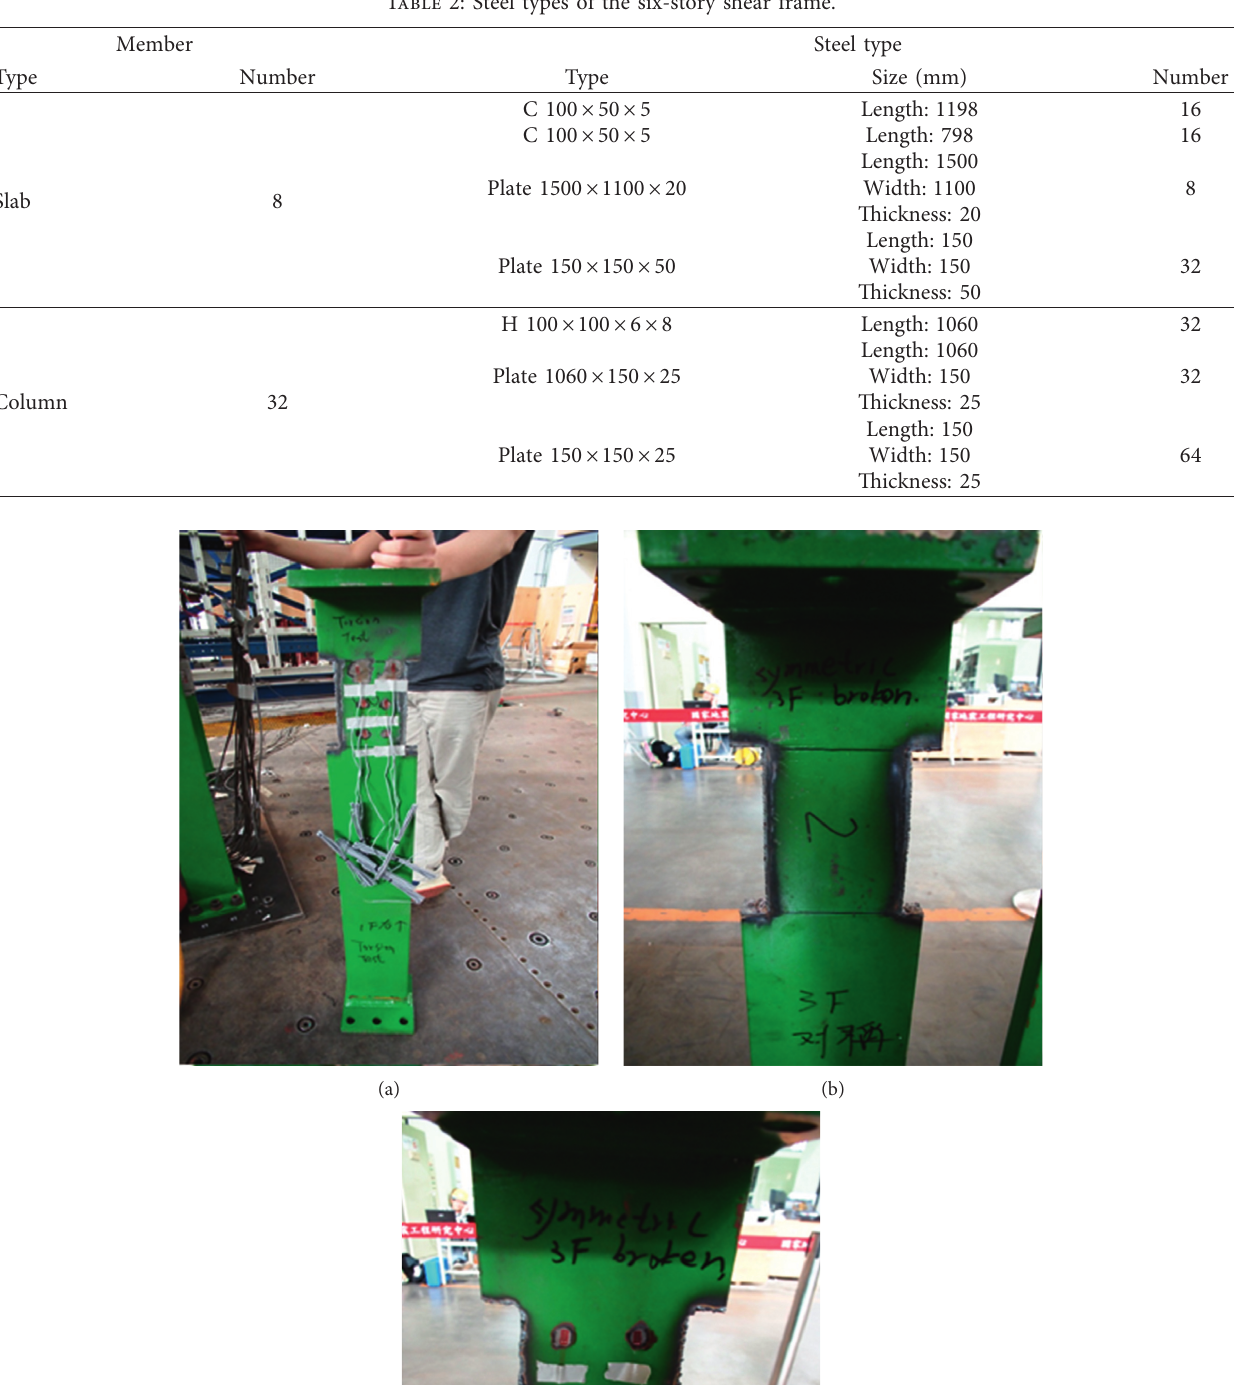
Table 2: Steel types of the six-story shear frame.